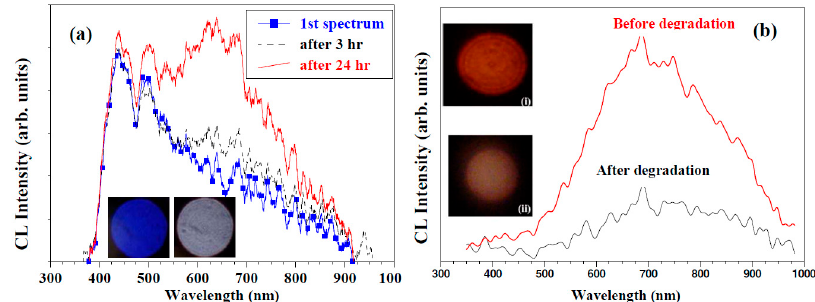
Figure 7. CL intensity against the wavelength for the light emitted from the powders: ( a ) before and after 3 h and 24 h electron bombardment of Y 2 SiO 5 :Ce [42]; and ( b ) SiO 2 :PbS nanoparticles before and after degradation [47] with a 2 keV electron beam at a 1 × 10 − 7 Torr O 2 pressure. The digital images were taken before and after degradation.